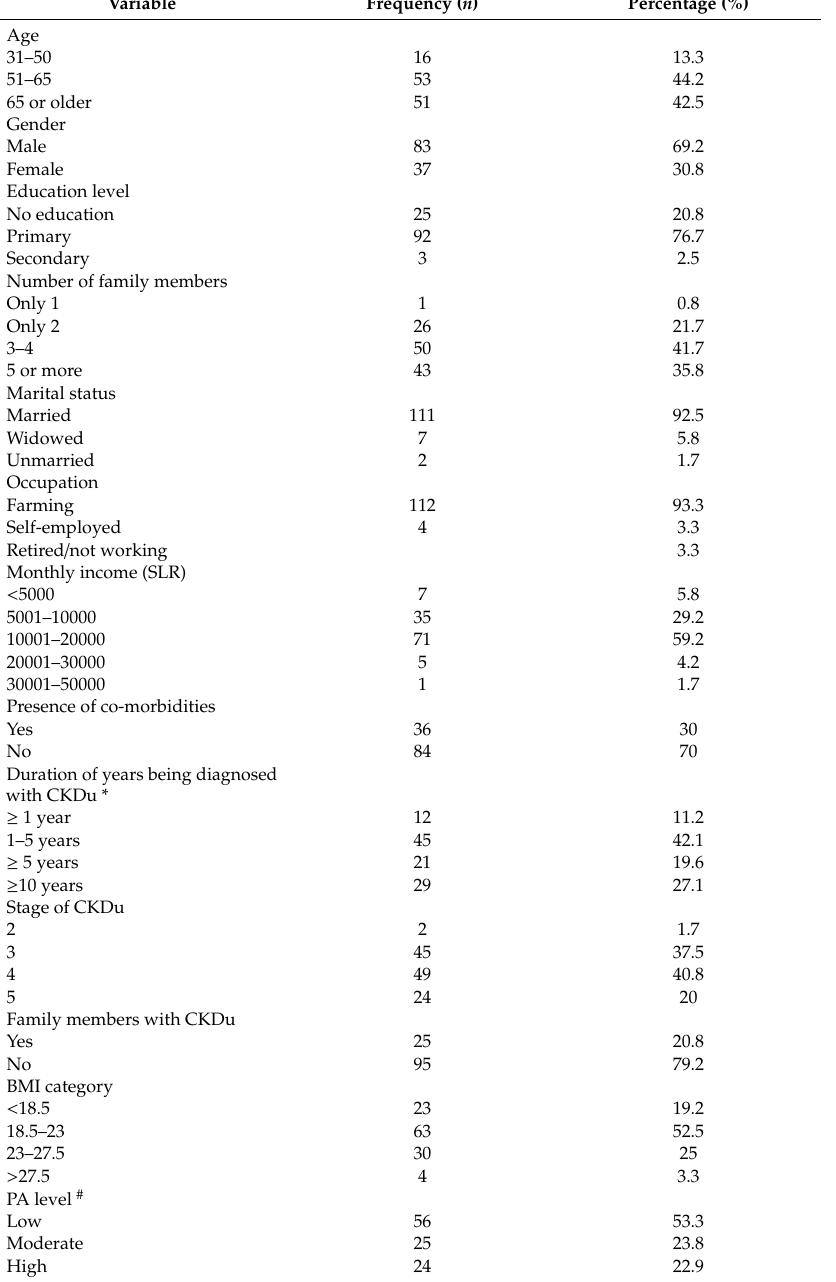
Table A1. Characteristics of the study